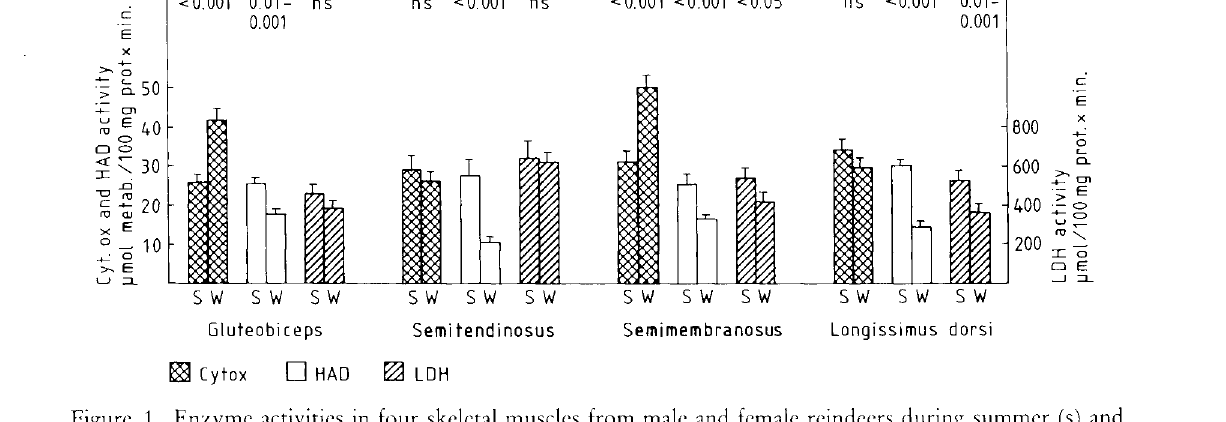
Figure 1. Enzyme activities in four skeletal muscles from male and female reindeers during summer (s) and winter (w) season.